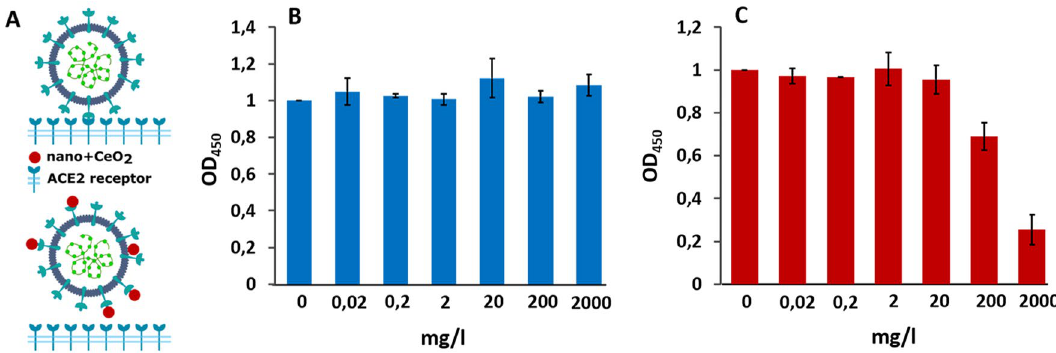
Figure 5. Schematics of the experiment ( A ), where the upper part shows SARS-CoV-2 binding to ACE2 receptor without nanoparticles and lower part demonstrates the theoretical inhibition of SARS-CoV2 binding to ACE2 receptor by of CeO 2 nanoparticles. ( B ) Shows the effect of nano-CeO 2 (+) and ( C ) the effect of nano- CeO 2 (−) particles on binding of SARS-CoV-2 onto ACE2 receptor in an ELISA assay, measured as optical density